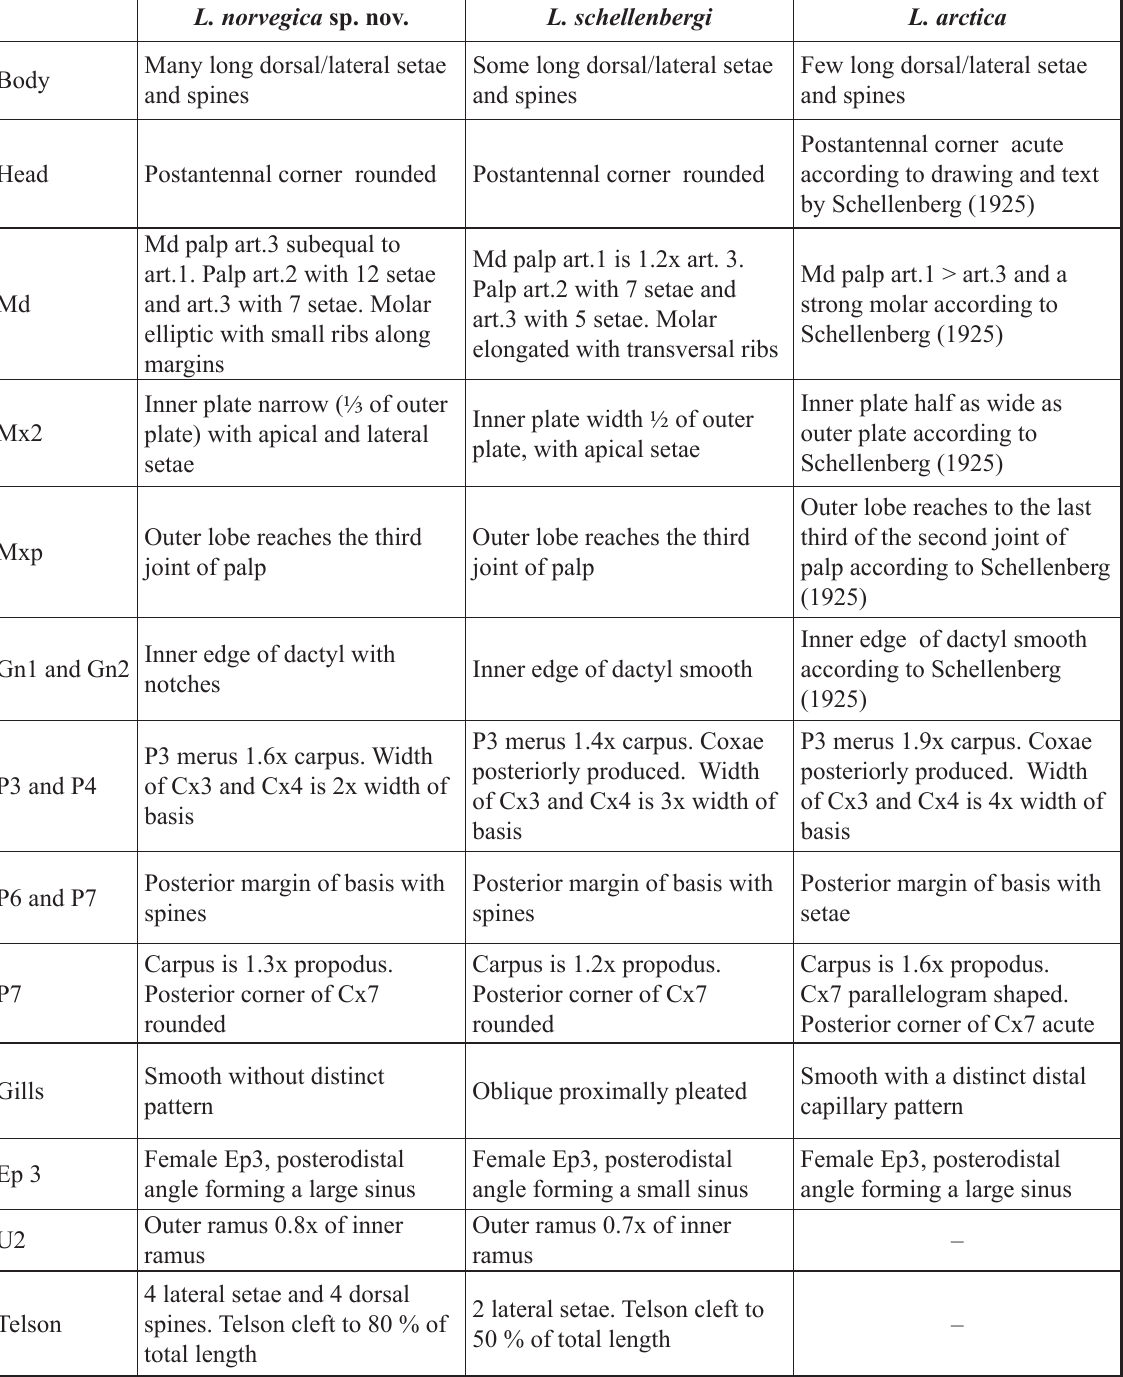
Table 1. Characters that separate Lepechinella arctica Schellenberg, 1926 , L. schellenbergi Stephensen, 1944 and L. norvegica sp.